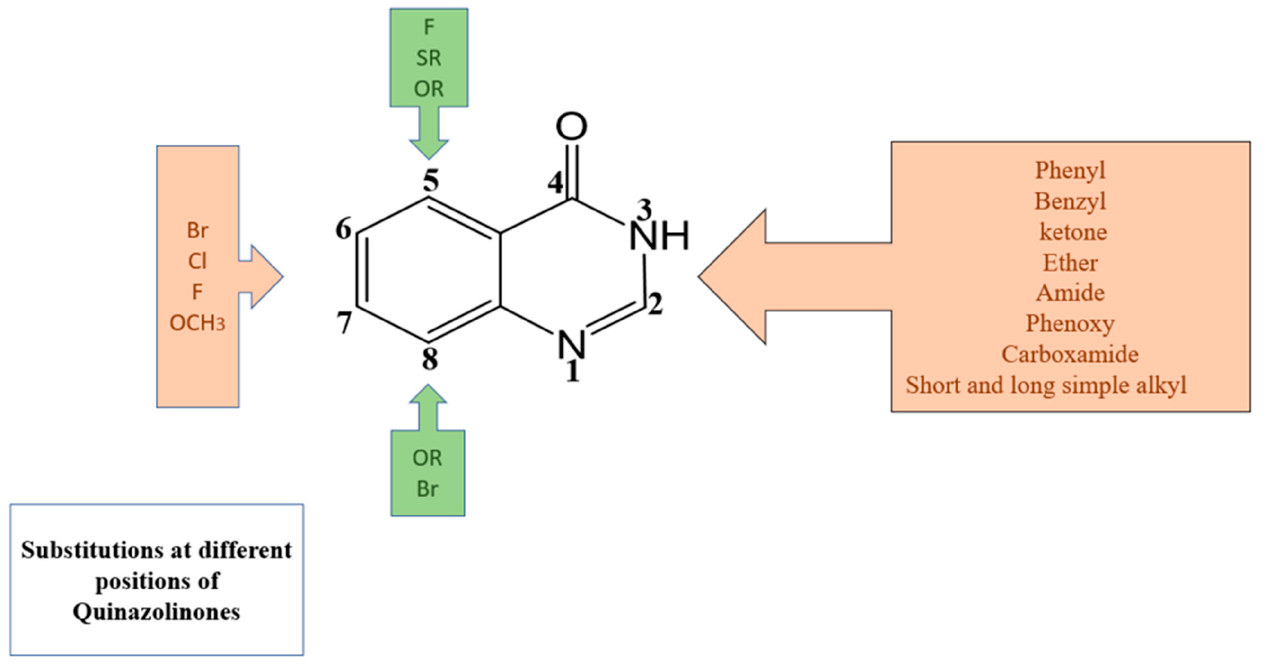
Figure 8. Substitutions at different positions of Figure 8 . Substitutions at different positions of quinazolinones.